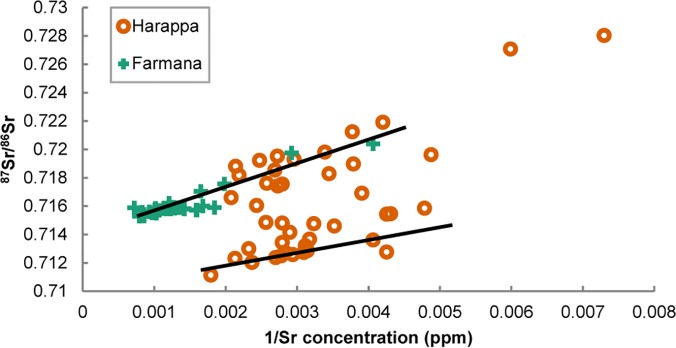
Two hypothesized Sr mixing systems based on Harappa and Farmana human data.The less radiogenic mixing system (87Sr/86Sr < ~0.716) is likely associated with Catchment A in Fig 1. The more radiogenic mixing system (87Sr/86Sr > ~0.716) is likely associated with Catchment B.